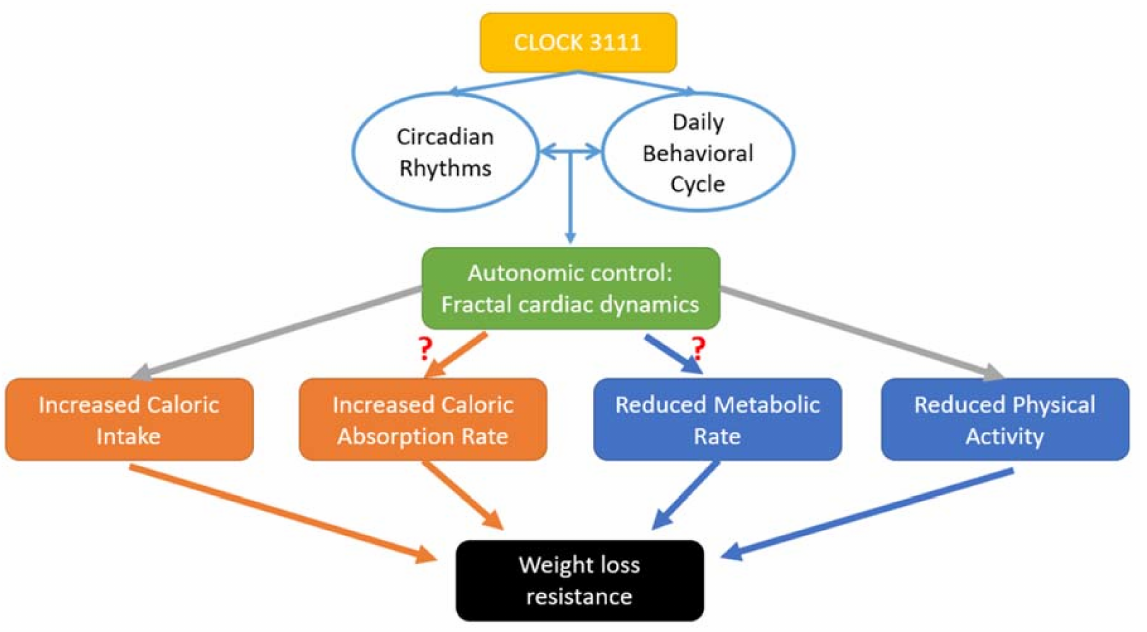
Figure 5. Hypothesized pathways for the genetic influences on weight loss